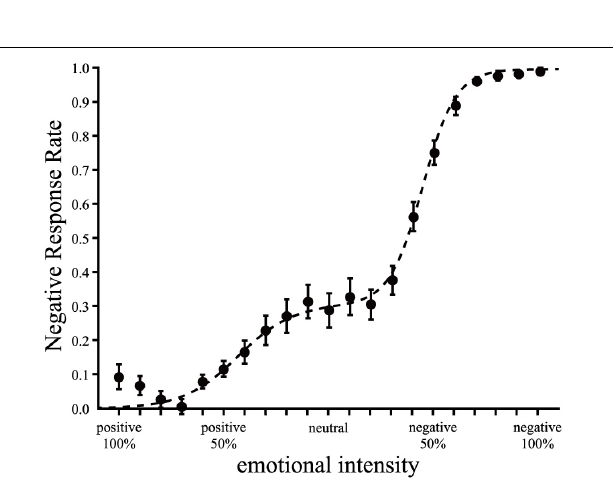
FIGURE 2 | Mean negative response rate for all participants and the fitted curves. The black circles represent the mean responses of participants each emotional intensity level. The broken line represents negative judgment curve which fitted to mean negative response for all participants. Error bars represent the standard